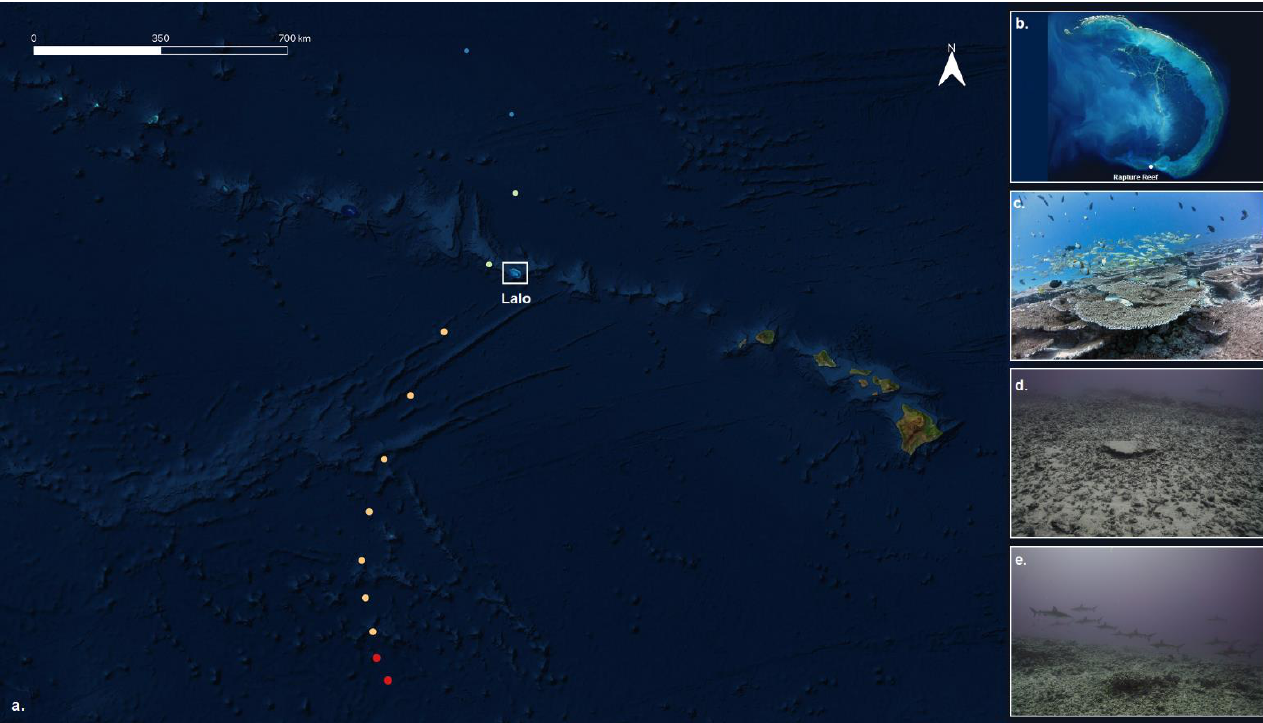
Figure 1. Maps of ( a ) the Hawaiian archipelago with the track of Walaka and ( b ) Lalo. The colors are showing the intensity: Categories 5 (red), 4 (yellow), 3 (green) and 2 (blue). Site photos of Rapture Reef from ( c ) 2017, ( d ) 2019 and ( e ) 2021 are also shown.